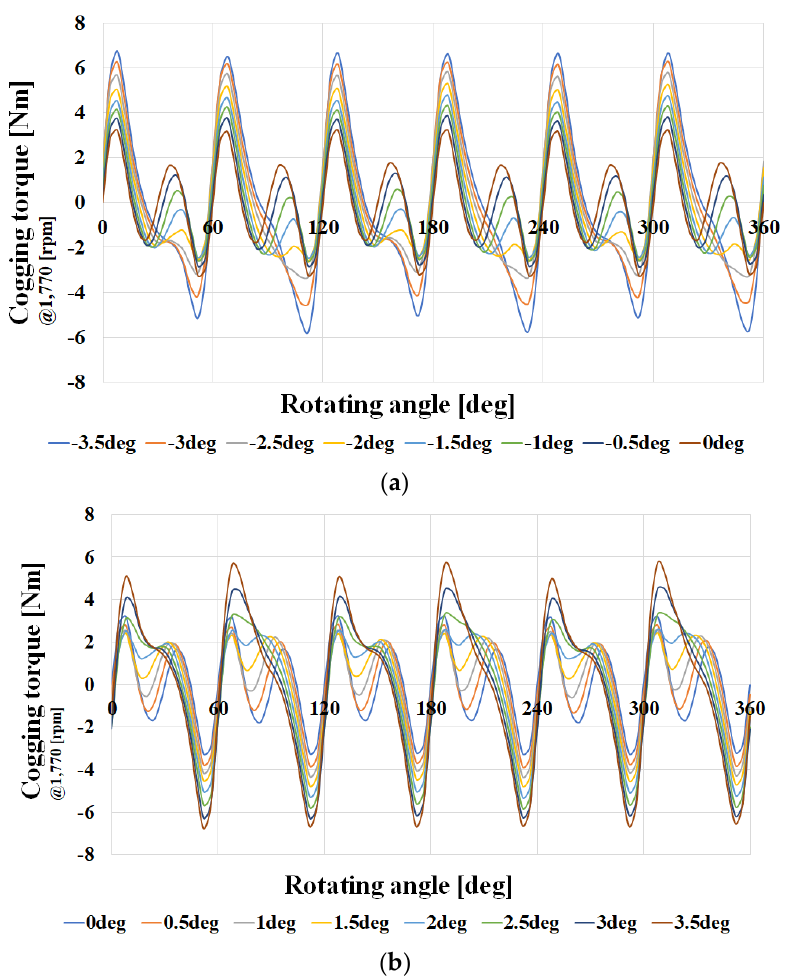
Figure 11. Cogging torque waveform depending on the two-stage skew tapering structure: ( a ) − 3.5 deg~0 deg; ( b ) 0 deg~3.5 deg.